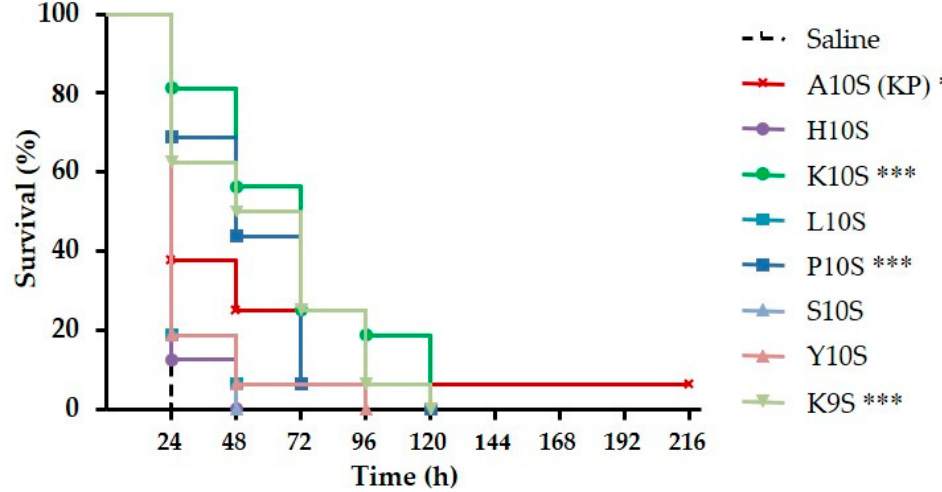
Figure 5. Therapeutic activity of KP-derivatives against experimental candidiasis in Galleria mellonella . Larvae were infected with 5 × 10 5 cells of C. albicans SC5314 and treated with peptides (11 µ mol/kg; single injection of 10 µ L) or saline solution (control group). The survival curves of larvae treated with KP, K10S, P10S, and K9S were significantly different from that of the control group, as assessed by Mantel-Cox log rank test (** p < 0.01, *** p < 0.001).